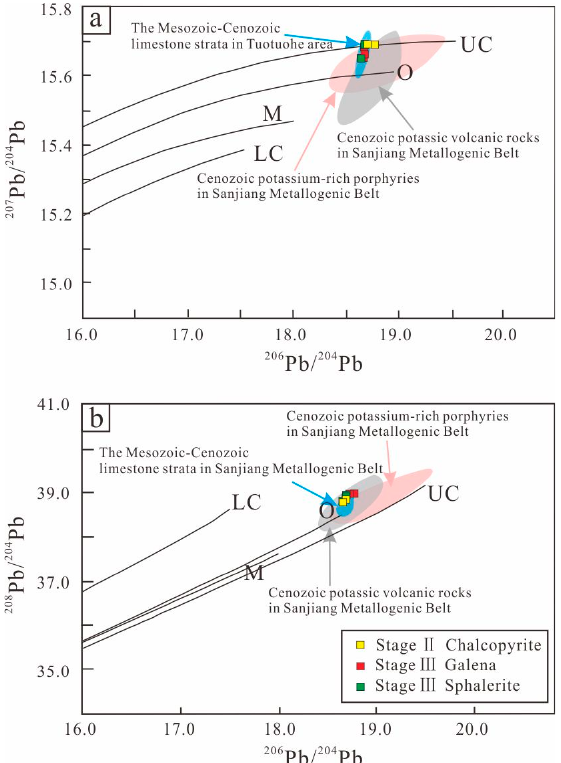
Figure 13. Lead isotope compositions for sulfides in the Chuduoqu Pb-Zn-Cu deposit. ( a ) 207 Pb/ 204 Pb versus 206 Pb/ 204 Pb plot; ( b ) 208 Pb/ 204 Pb versus 206 Pb/ 204 Pb plot. UC—upper crust, O—orogen, versus 206 Pb / 204 Pbplot; ( b ) 208 Pb / 204 Pbversus 206 Pb / 204 Pbplot. UC—uppercrust, O—orogen,